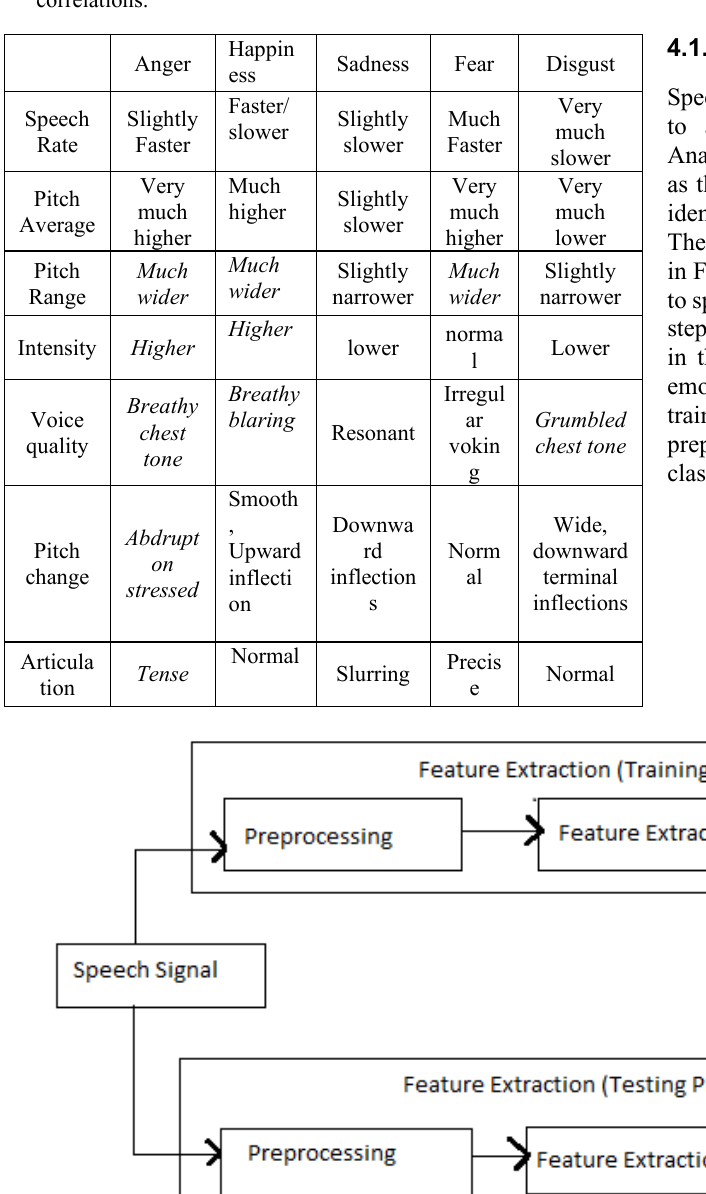
Table 1. A Summary of the most common spoken emotion correlations.